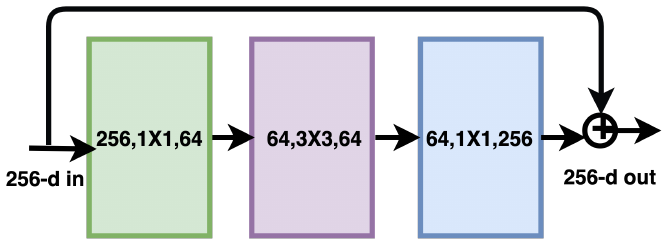
Figure 5. Basic building block of the Residual Network.